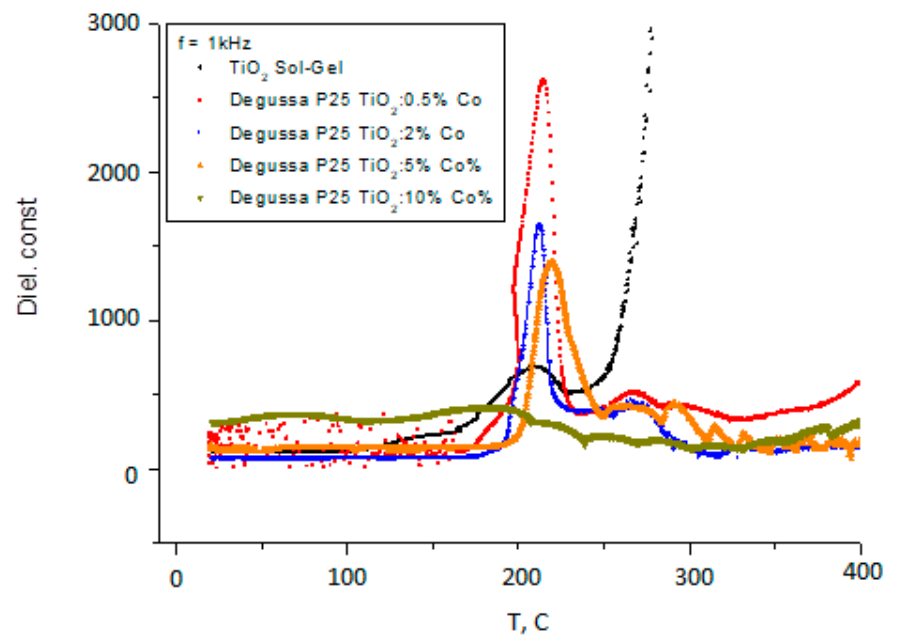
Figure 6. Dielectric constant of Degussa P25 TiO 2 sample doped with different contents of Co. dielectric anomalies located at ~250 ◦ C and ~700 ◦ C, respectively. These anomalies